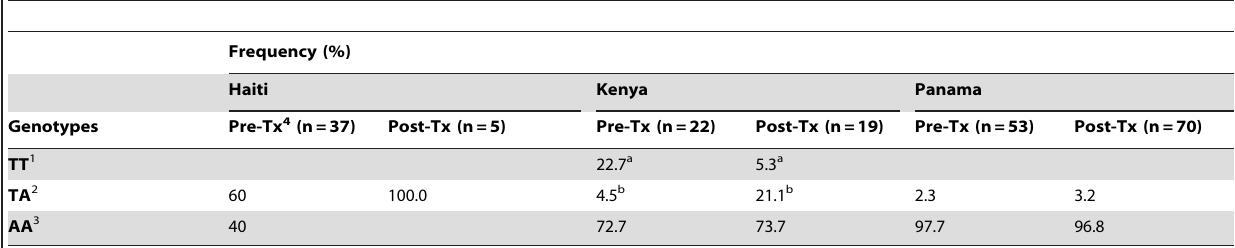
Table 1. Genotype frequencies of b -tubulin position 167 in A. lumbricoides before and after ABZ treatment.